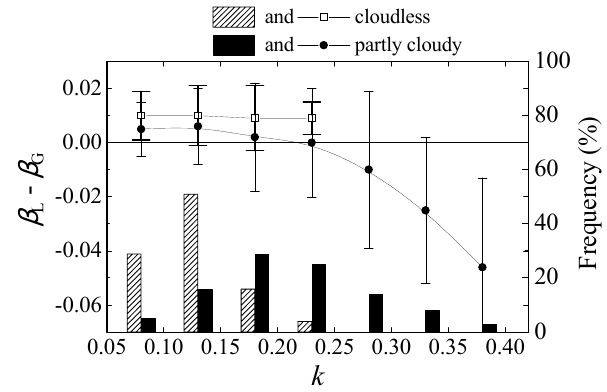
Fig. 8. Average differences β L (α sunphot ) − β G versus the hourly diffuse fraction k for both totally cloud-free and partly cloudy sky conditions. Percentage frequency distribution of the diffuse fraction for the two types of sky conditions is also